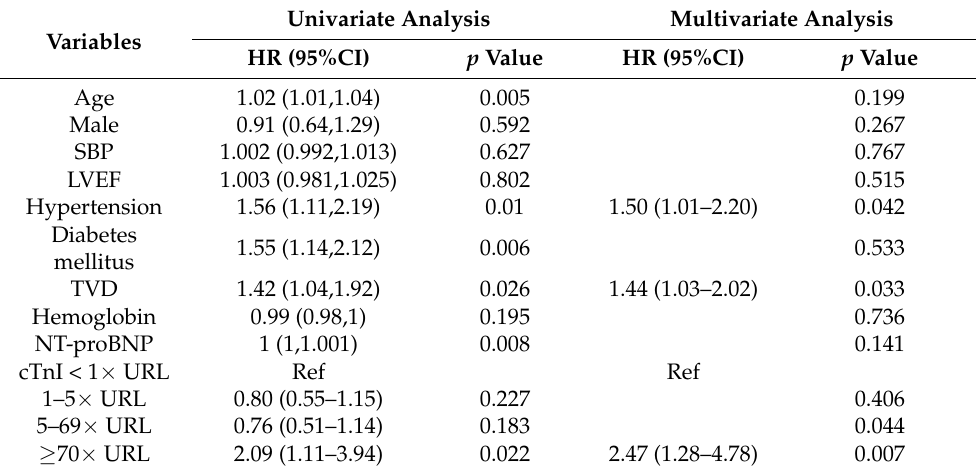
Table 2. Univariate and multivariate predictors of 5-year MACE in the total cohort assessed by Cox regression